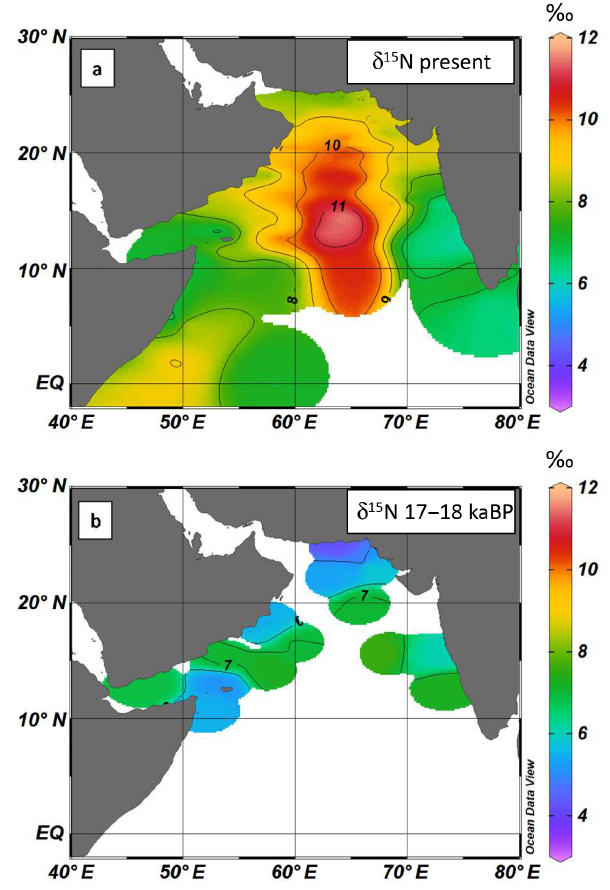
Figure 5. The δ 15 N values in ‰ in recent surface sediments (a) ; δ 15 N in sediments at 17–18kaBP (b) from surface and core loca- tions shown in Fig.